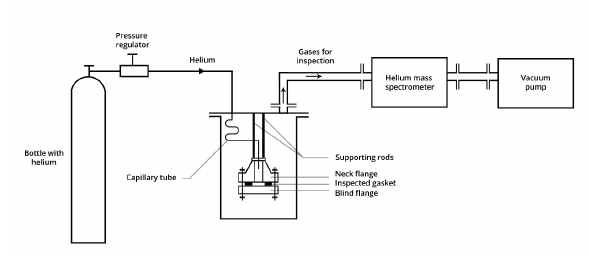
Figure 1: Scheme of the experimental test rig for assessing the leak- age of flanged joint operating at cryogenic temperature.